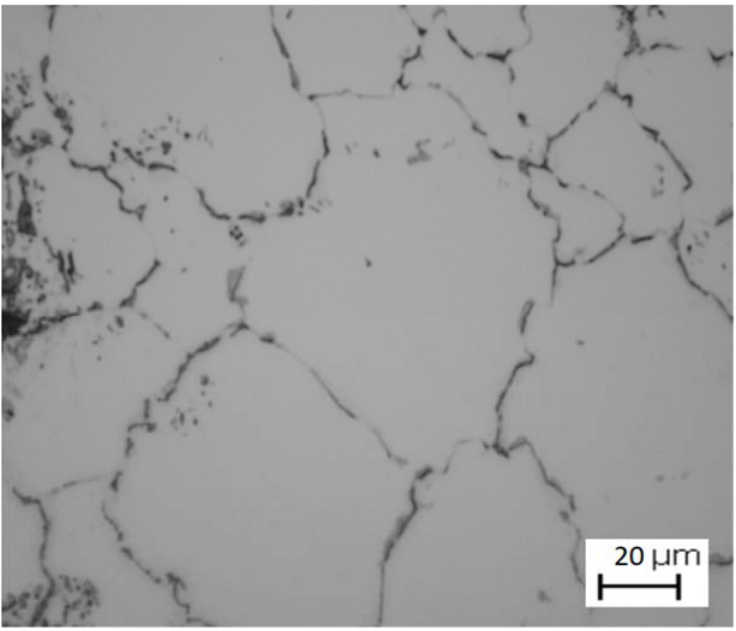
Figure 8. Sintered duplex stainless–steel UNS S31803/Vanadium carbide microstructure at 1250 °C for 1 h.